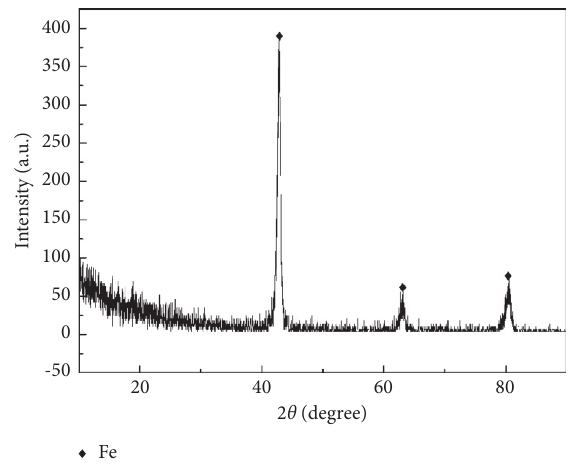
Figure 6: XRD pattern collected for the sample fabricated by WAAM.